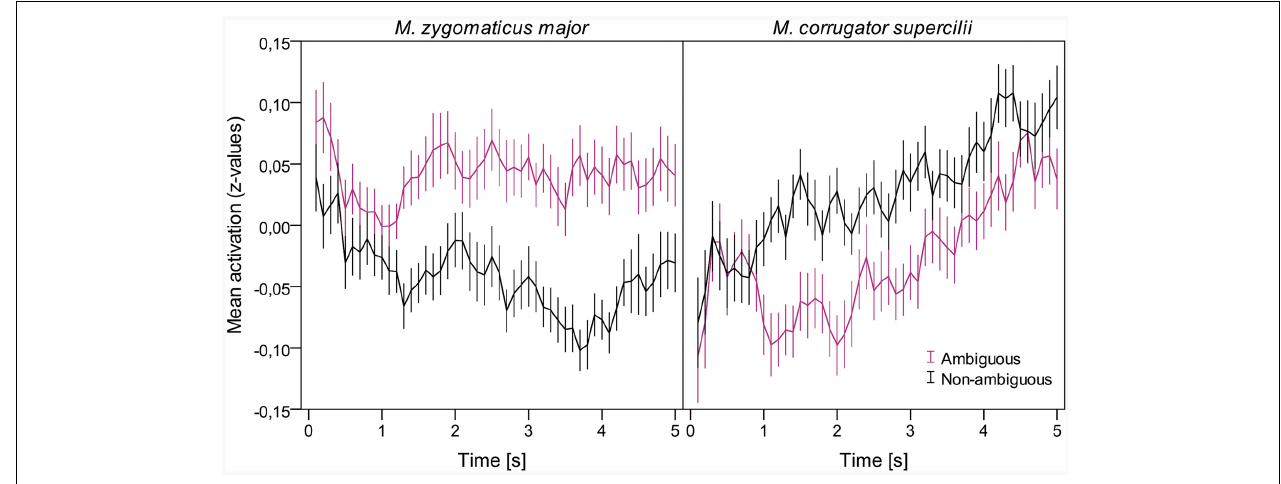
FIGURE 1 | Time course of the z-standardized (within-participant) activation of the M. corrugator supercilii and M. zygomaticus major regions, plotted separately for ambiguous and non-ambiguous artworks. Error bars show standard